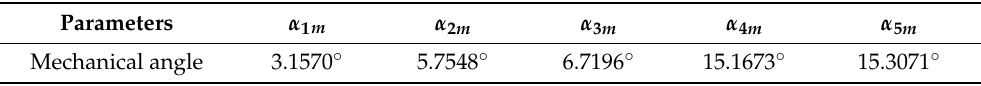
Table 5. Actual parameters of sin + 3rd harmonic magnetic pole position angle.